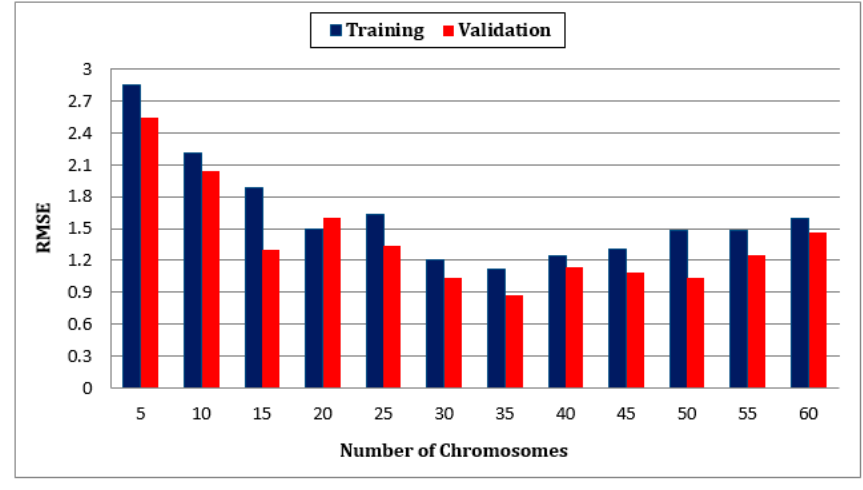
Figure 10. Comparison between root mean square error ( RMSE ) of training and validation for different numbers of chromosomes.